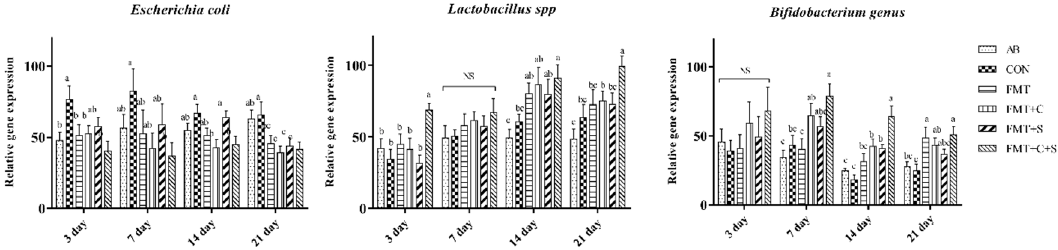
Figure 2. Effects of different early intervention model on the intestinal microbiota structure in piglets. All values are presented as means ± SEM ( n = 10–12). a,b,c Values within a row with different superscripts differ significantly at p < 0.05.